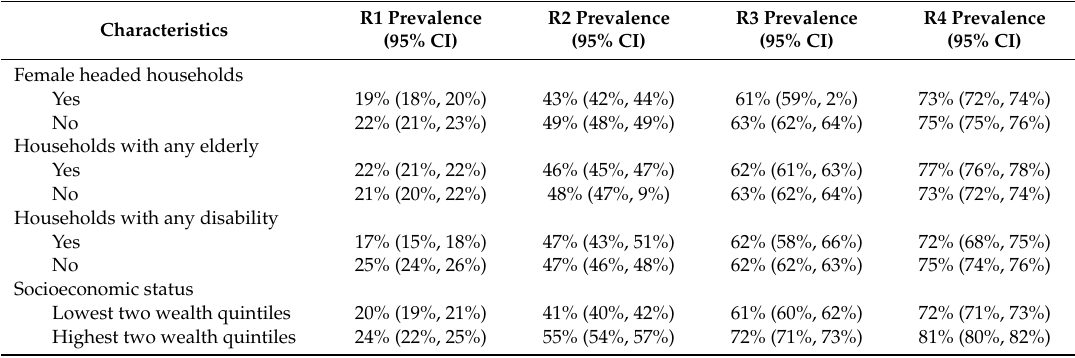
Table A2. Basic sanitation coverage over time, compared between vulnerable and non-vulnerable groups. Data are aggregated across all countries.